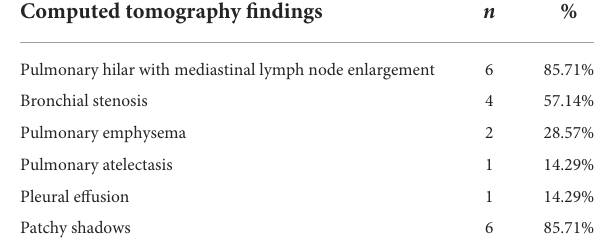
TABLE 1 Demographic characteristics of the patients. TABLE 2 Computed tomography findings of the patients before